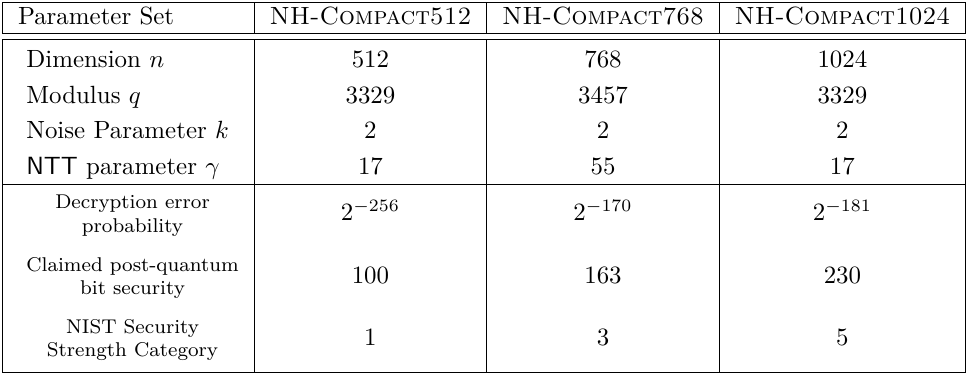
Table 2: Parameters of NewHope-Compact512 , NewHope-Compact768 and NewHope-Compact1024 and derived high-level properties